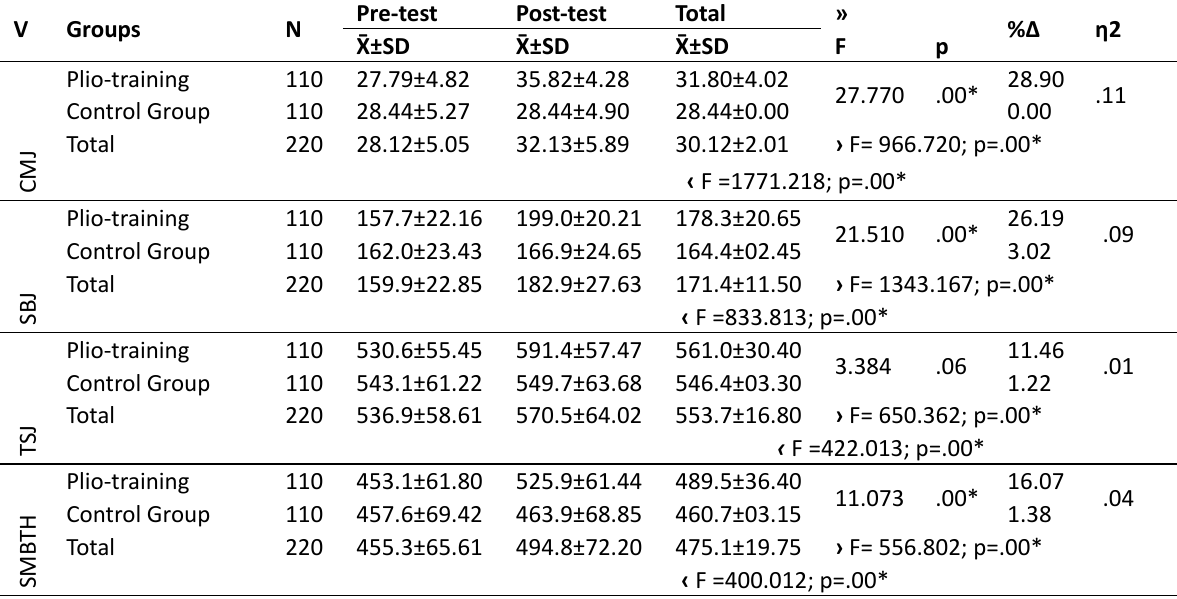
Table 3. Impact of plyometric training with respect to power ability (explosive force) factors